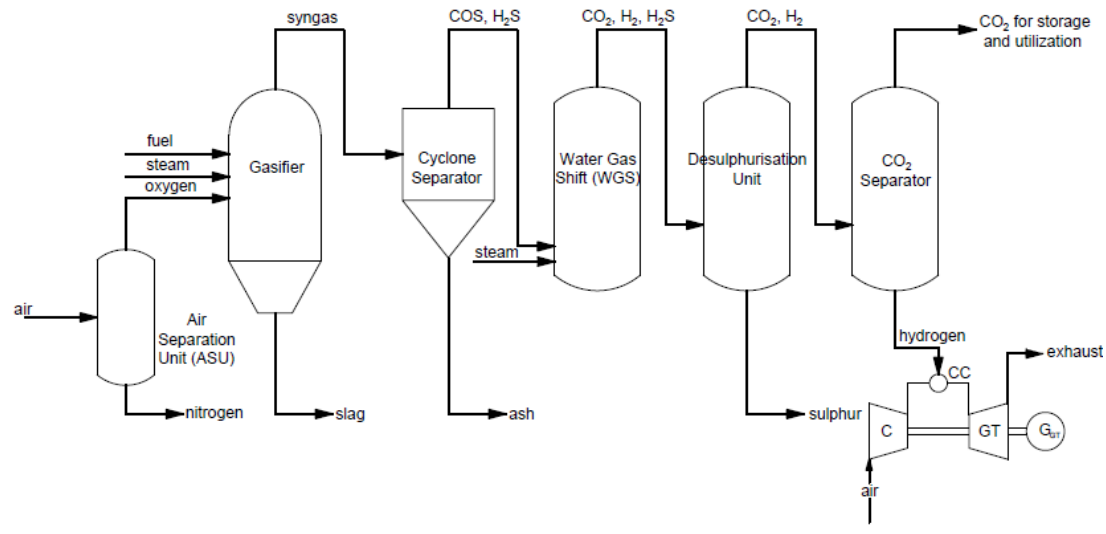
Figure 3. Scheme of integrated gasification combined cycle (IGCC) for electricity generation using a gas turbine using the pre-combustion CO 2 capture method.